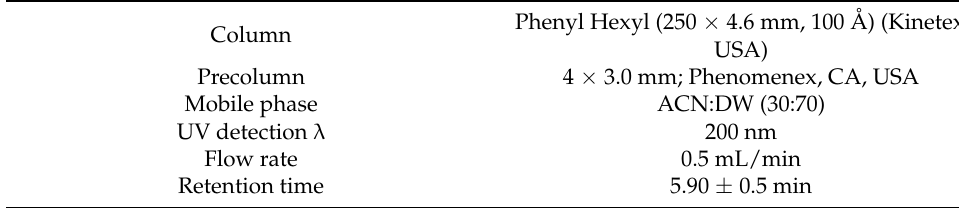
Table 4. Chromatographic